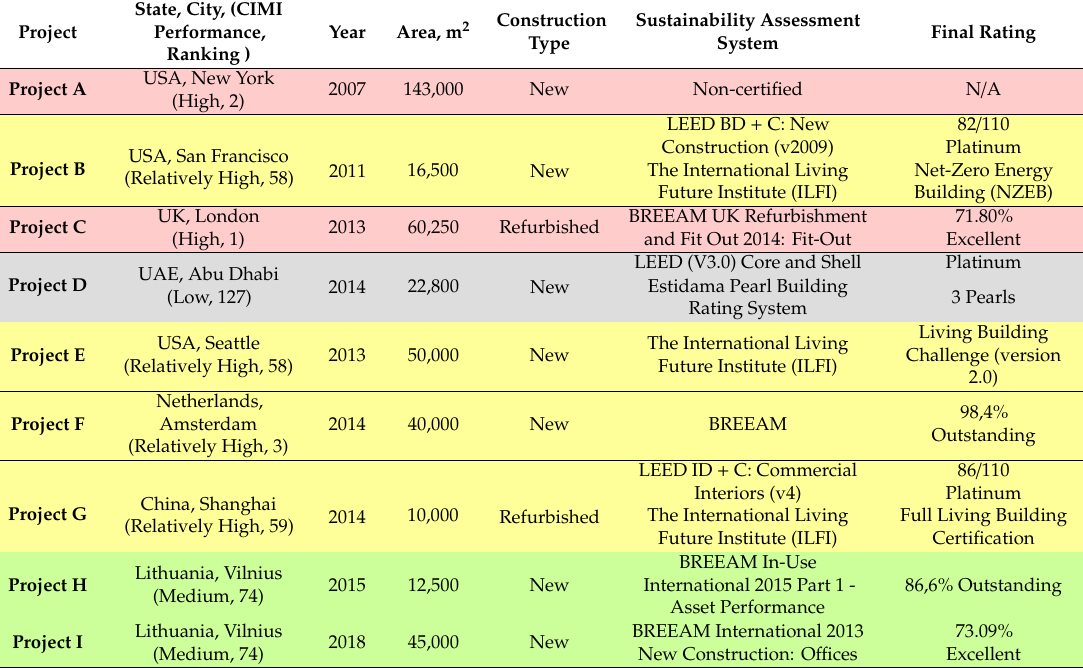
Table 10. Overview of the